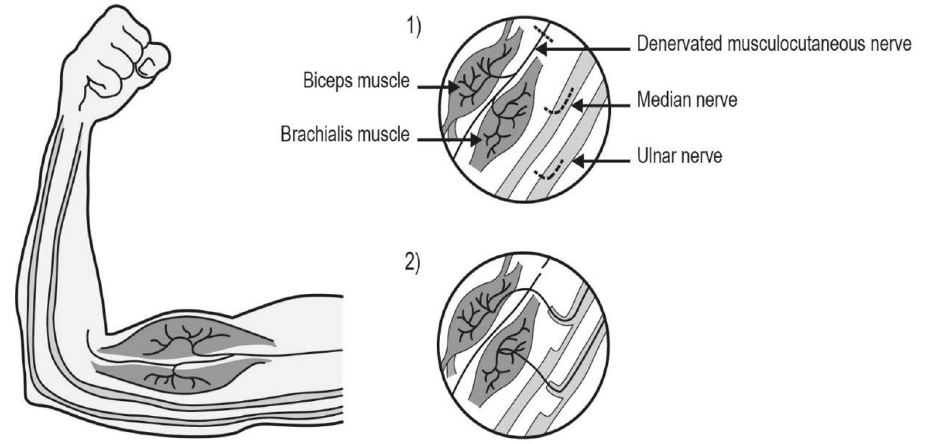
Figure 4. Nerve transfer to reanimate elbow flexion 43 . Restoration of elbow flexion is a common challenge encountered by the reconstructive surgeon following injury to the upper cervical roots, upper trunk, lateral cord and/or musculocutaneous nerve. The surgeon performs a neurotomy in the longitudinal orientation along donor median and ulnar nerves. Using low amplitude stimulation, a fascicle (no greater that 1/8th the size of the donor nerve) that demonstrates predominantly wrist flexor activity (flexor carpi ulnaris/flexor carpi radialis) is identified. Other fascicles are subsequently stimulated to ensure that wrist flexion would be maintained following donor harvest. Fascicles that demonstrate intrinsic hand function upon stimulation are avoided. The donor median and/or ulnar fascicles are then transferred into the chronically denervated stump of the biceps branch of the musculocutaneous